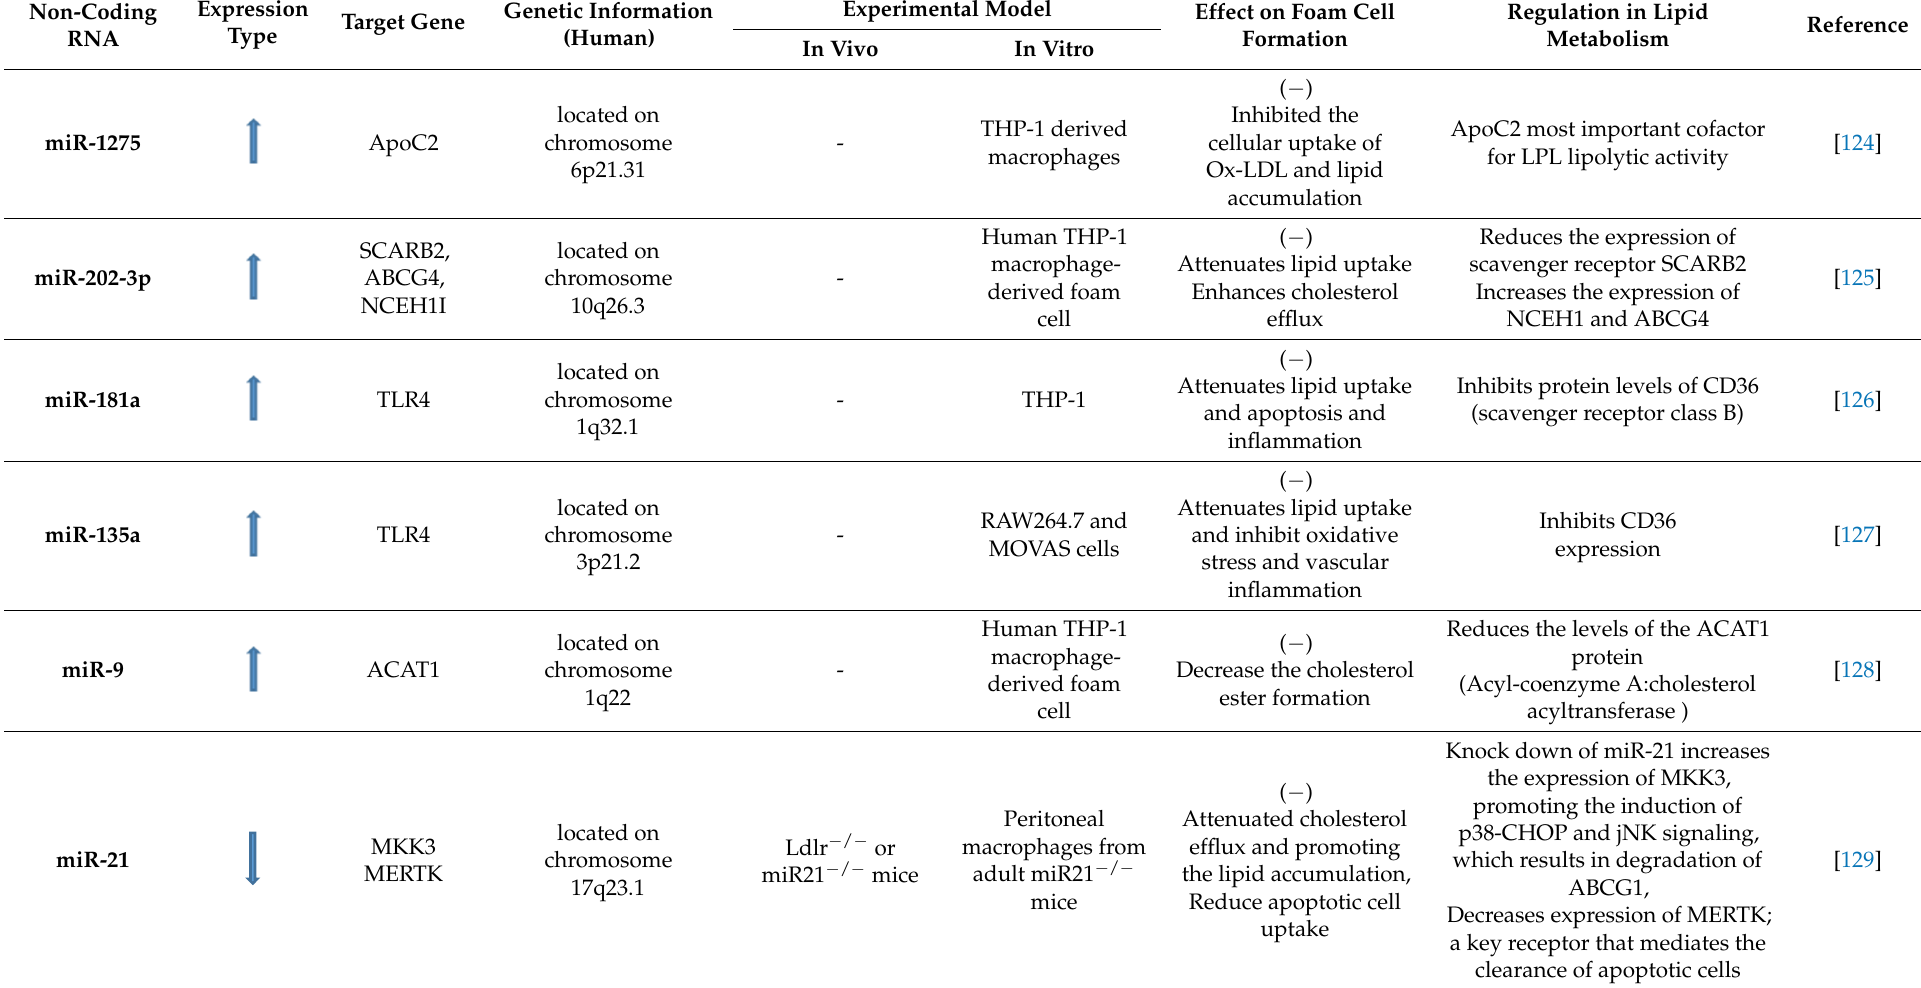
Table 2. Non-coding RNAs that attenuate foam cell formation/function.